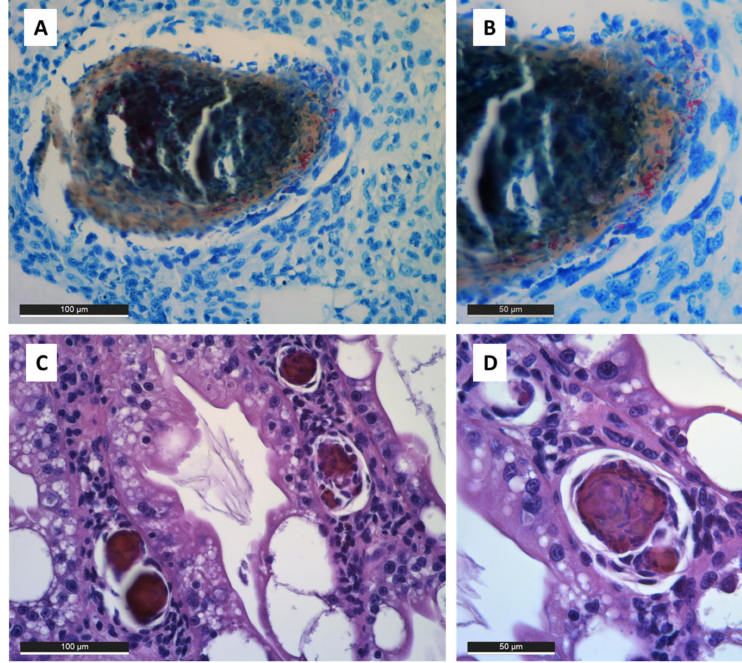
Figure 2. Histopathology of mycobacteriosis in redclaw crayfish ( Cherax quadricarinatus ) tissues. ( A ) Gill tissue with melanised haemocytic aggregation (ZN). ( B ) Detail of haemocytic reaction in the gill with evidence of many magenta-stained acid-fast bacilli attributed to the genus Mycobacterium (ZN). ( C ) Melanised haemocytic aggregations in the haemal spaces of the hepatopancreas (H&E). ( D ) Detail of melanised aggregation in the hepatopancreas (H&E). H&E: haematoxylin and eosin; ZN: